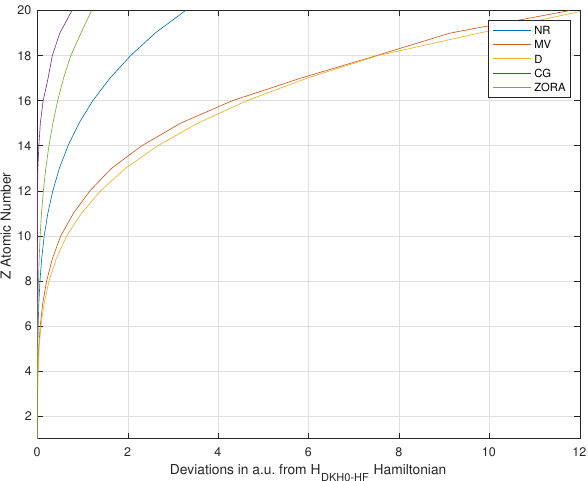
Figure 2. Absolute deviations in a.u. from Douglas-Kroll-Hess 0 th order–Hartree–Fock Hamiltonian. Without relativistic effects it is not possible to obtain a correct description of molecular properties. This applies, in particular, for the induced current density that contains contri- butions arising from electron spin and that are not negligible for open-shell systems [5,44]. For closed-shell systems, only small differences in detail were found in the magnetically induced currents maps obtained at the different levels of calculations